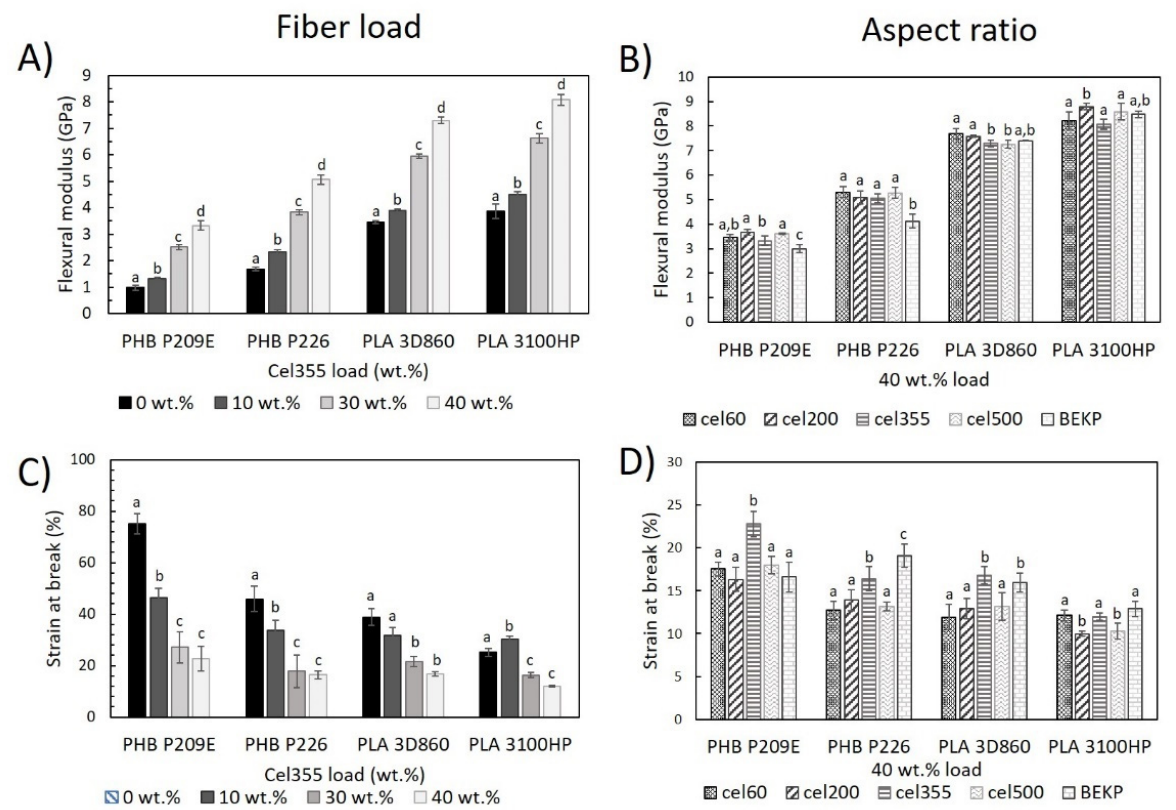
Figure 6. Flexural properties of) the PHB- and PLA-based composites reinforced ( A , C ) with different loads of Cel355 and ( B , D ) with fibers having different aspect ratios for a load of 40 wt.%. Different letters (a,b,c,d) indicate statistically significant differences ( p < 0.05).